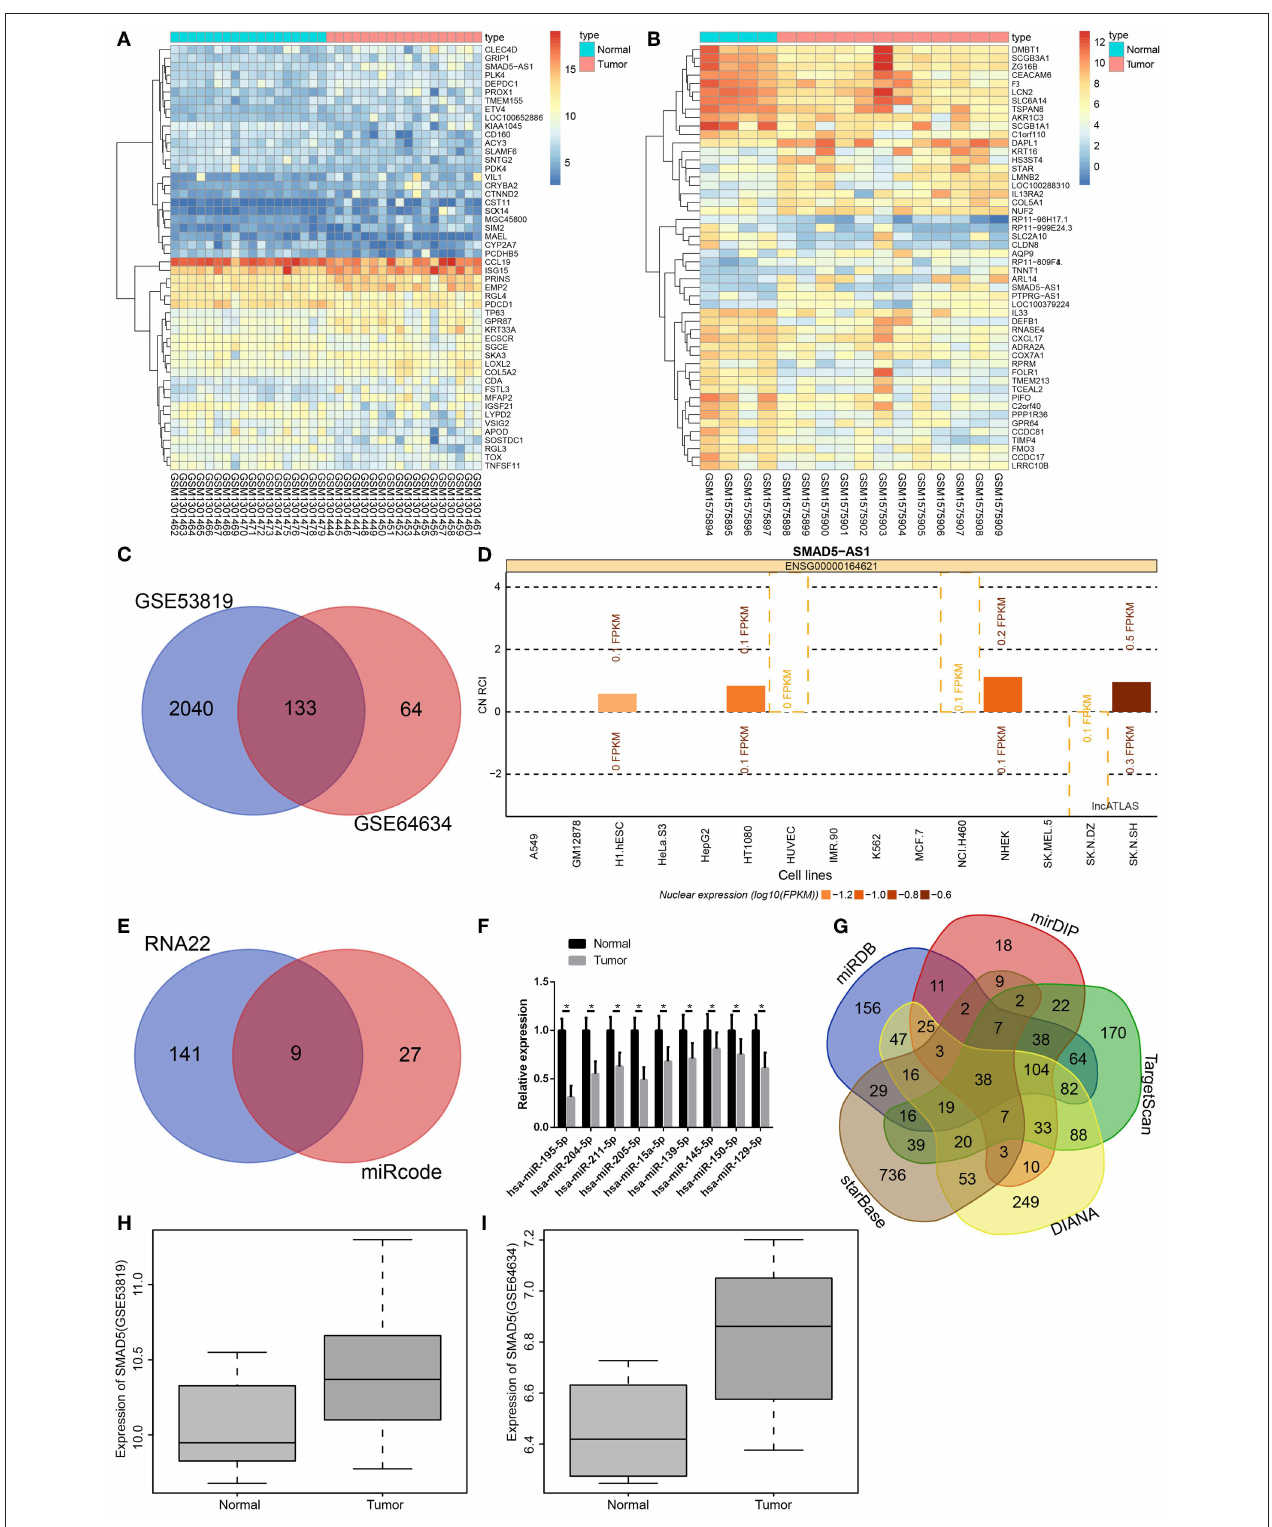
FIGURE 1 | SMAD5-AS1, SMAD5, and miR-195 might be involved in NPC. (A,B) Heat maps of DEGs in NPC expression datasets GSE53819 and GSE64634, in which the abscissa represents the sample number, and the ordinate represents the DEGs; the dendrogram on the left refers to gene expression cluster;